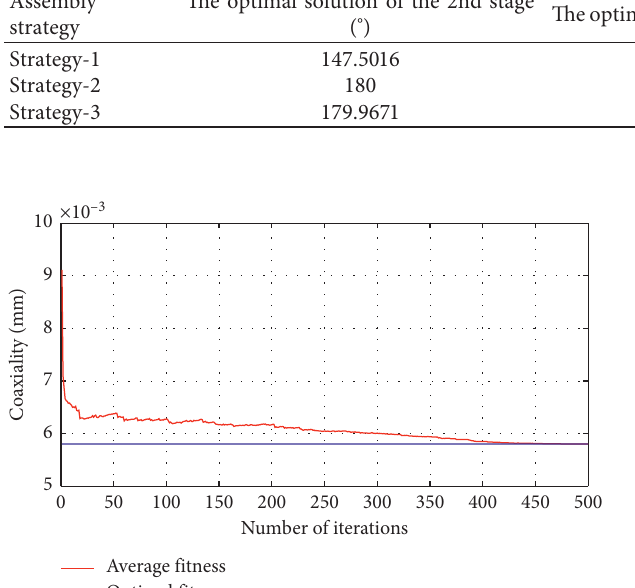
Figure 5: The convergence progress of the single-objective opti- mization for the coaxiality.